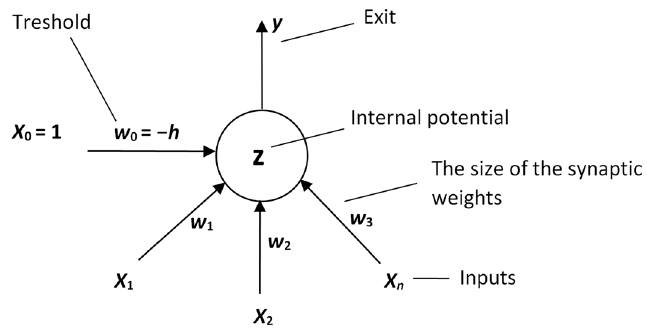
Figure 1. Formal neuron schema.